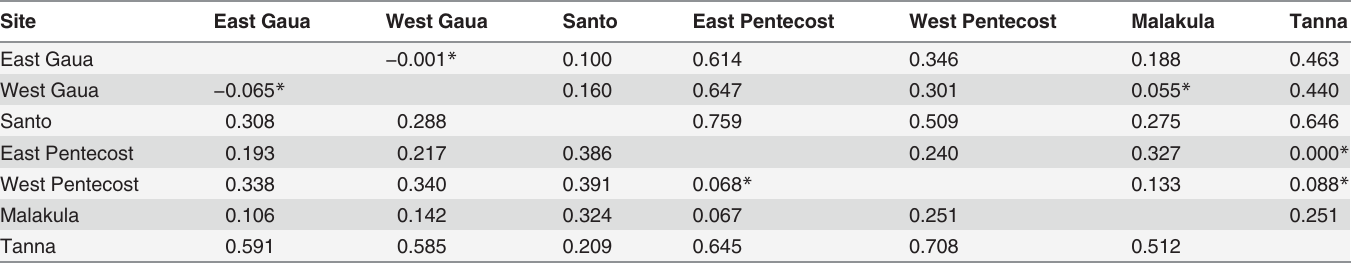
Table 3. Pairwise F ST genetic distances based on msp1 (lower triangle) and csp (upper triangle) haplotype frequencies in P . falciparum from seven sites in Vanuatu. Site